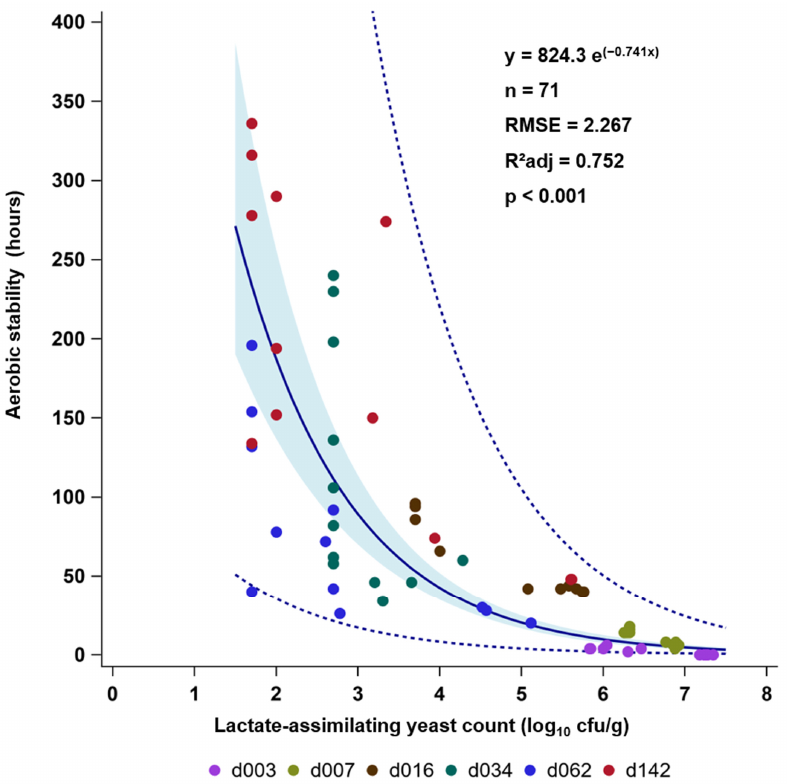
Figure 4. Relationship between the count of lactate-assimilating yeasts and aerobic stability of maize silage determined on day 3 (d003), day 7 (d007), day 16 (d016), day 34 (d034), day 62 (d062), and day 142 (d142) of storage.